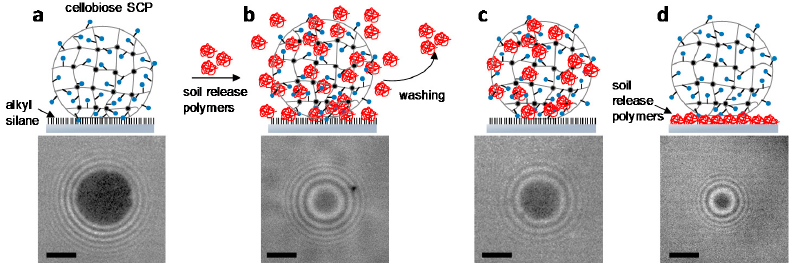
Figure 7. Sketches of adhesion experiments with soil release polymers ( top ) and typical SCP contact areas ( bottom ). ( a ) adhesion of bare cellobiose SCPs on hydrophobic glass as reference; ( b ) in presence of polymer samples (antiredepostion experiment); ( c ) after removal of the polymers by centrifugation and washing (antiadhesive coating experiment); ( d ) direct binding of cellobiose SCPs on polymer surfaces (direct binding experiment). Scale bars: 2 µm.